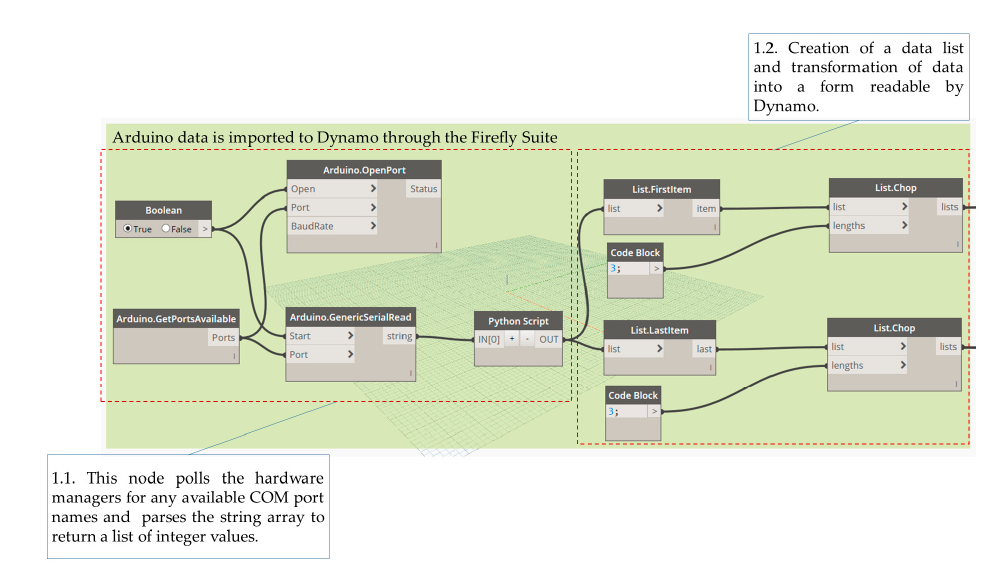
Figure 7. Arduino and Dynamo linking process.